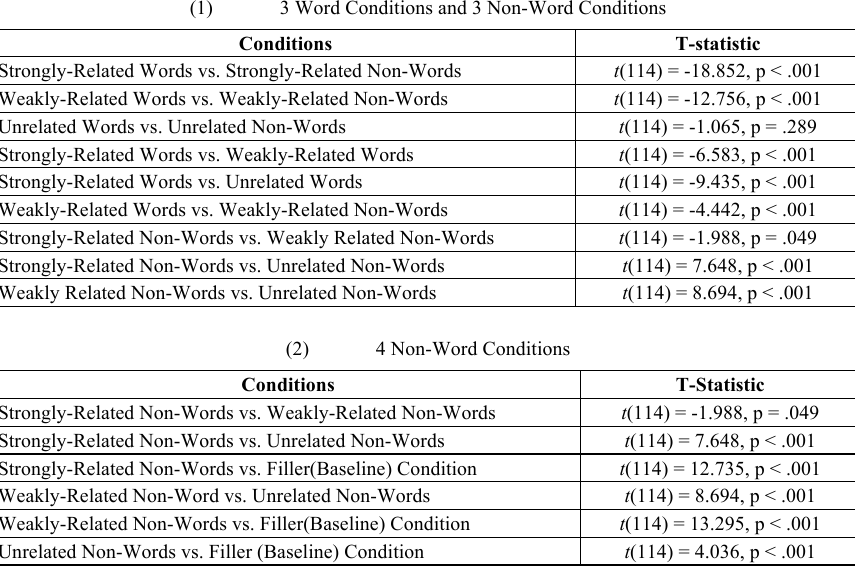
Table 5. Paired-Samples T-Test for Experiment